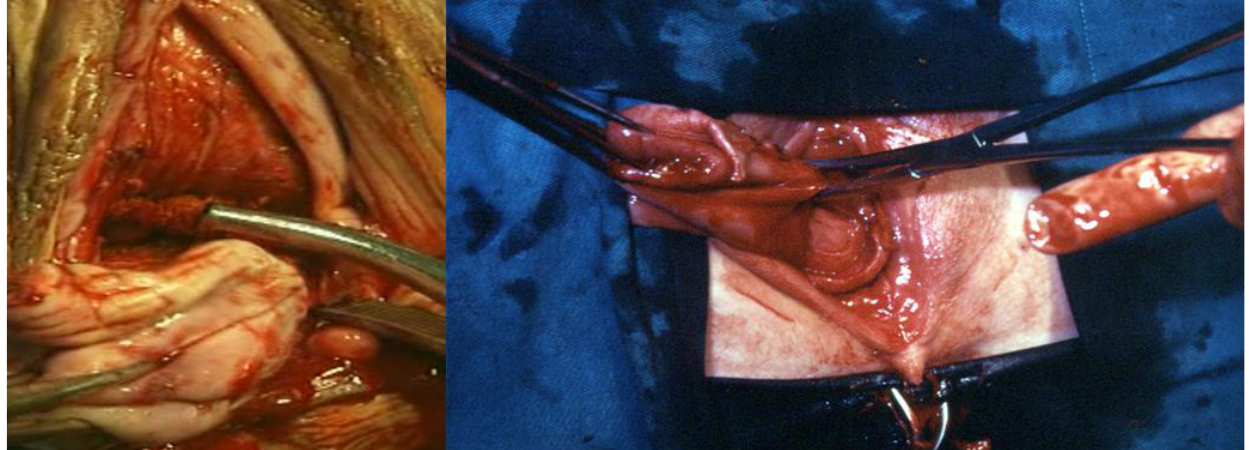
Figure 4. On the left, the lower blade of the Heany clamp is placed under the sacrouterine ligament; on the right, while rotating the uterus clockwise (in the left side of the uterus), the uterosacral ligaments are held together with the paracervical tissues and subsequently dissected and ligated. 5. Cutting and ligating the uterine arteries (Figure 5);